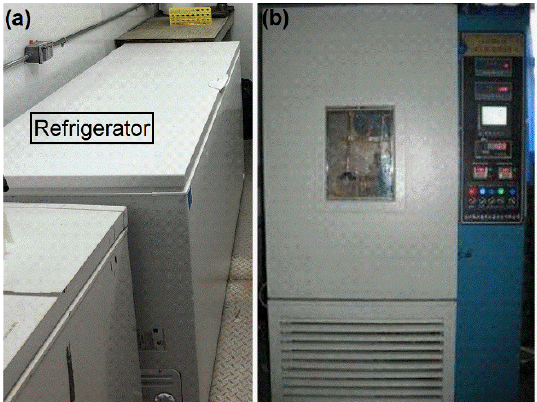
Figure 2. F/T setups: ( a ) a commonly used refrigerator and ( b ) a 3D F/T system (adapted from [ 70]).